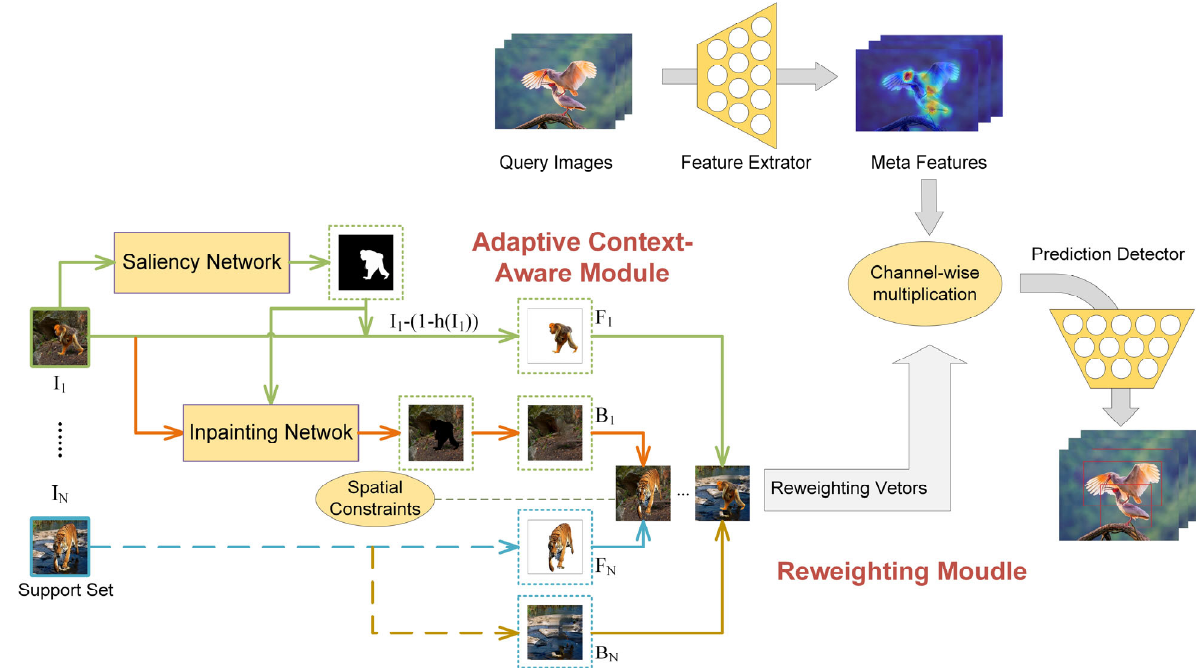
Figure 1. An overview of the proposed framework for few ‐ shot endangered ‐ animal detection.